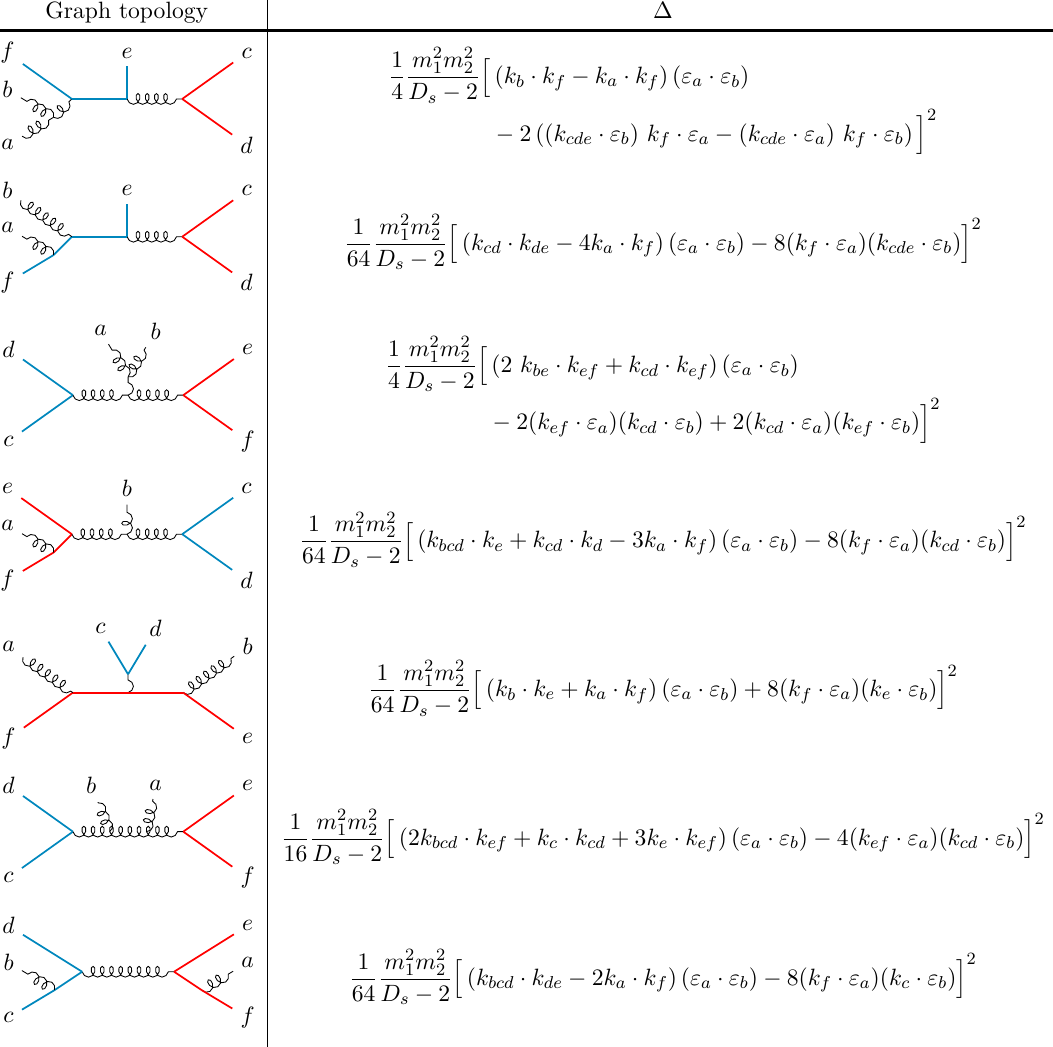
Table 3 . The graph topologies for the six-point tree amplitude for two distinct-mass scalars, and the corresponding contributions from non-gravitational states ∆ , where k ij = k i + k j